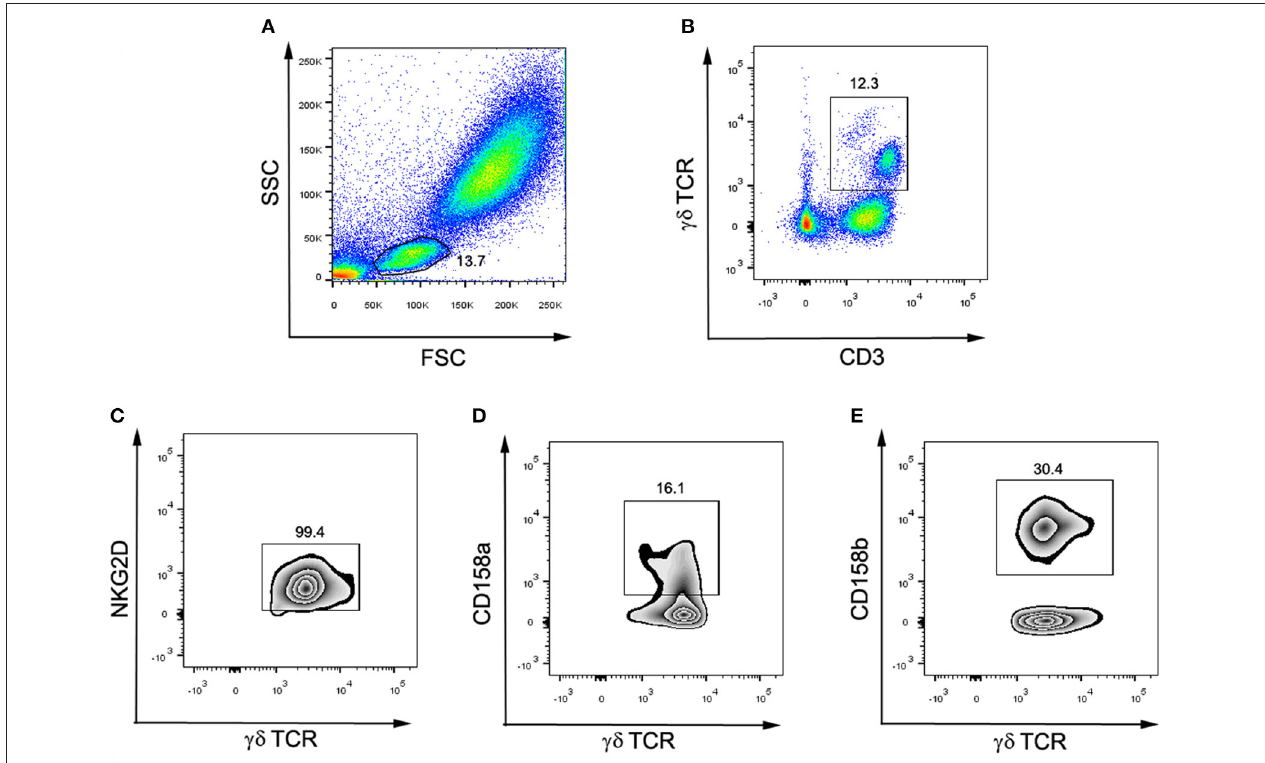
FIGURE 2 | Flow cytometry gating strategy for surface markers and γδ -T cell subsets. (A) The lymphocytes were gated by FSC and SSC. (B) CD3 + γδ TCR + cells were defined as γδ -T cells. (C) Among γδ -T cells, NKG2D + γδ TCR + were defined as NKG2D + γδ -T cells. (D) Among γδ -T cells, CD158a + γδ TCR + were defined